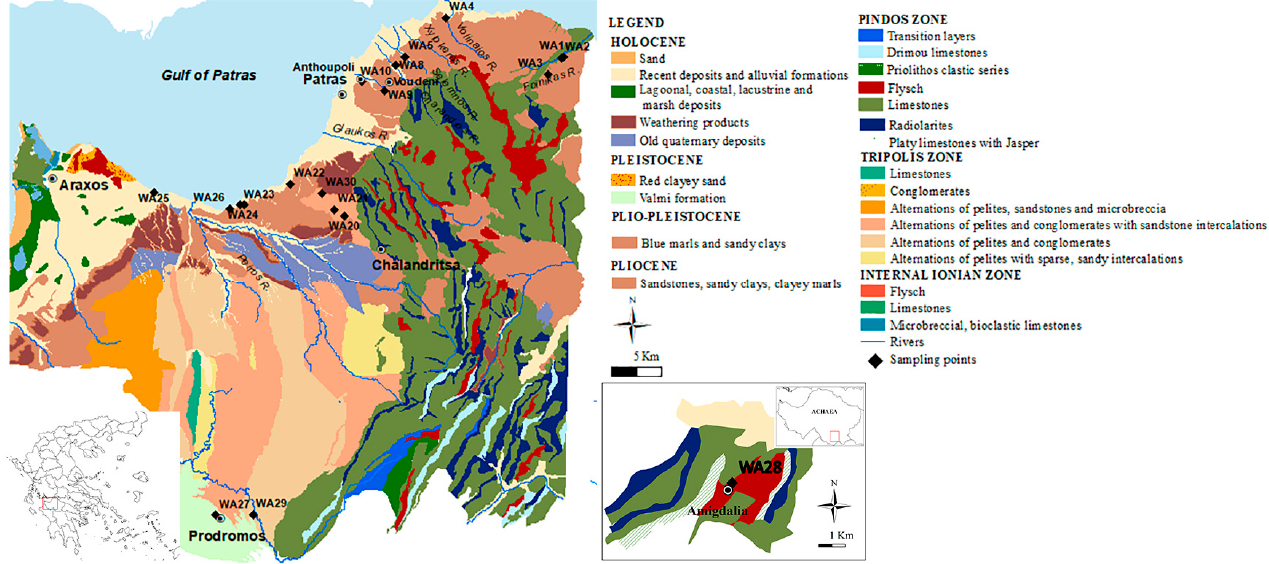
Figure 1. Modified geological map of Western Achaea, combined from IGME sheets of Nafpaktos, Patrai, Khalandritsa, Kertezi, Nea Manolas, Goumeron, and Dafni [13–18]. In western Achaea, the Ionian zone outcrops over a limited area, due to the coverage by the Neogene and Quaternary deposits, and is limited to the north-western part of the prefecture, in the broader area of Araxos. The lithostratigraphic structure of the zone is described in the geological sheet “N. Manolada” of IGME, and is composed mainly of limestones and flysch. At the southwestern end of the prefecture, the sedimentary series of the Gavrovo-Tripoli zone develops (Figure 2). The zone is mainly structured by dolomites and limestones of different geological ages, as well as Oligocene and Eocene